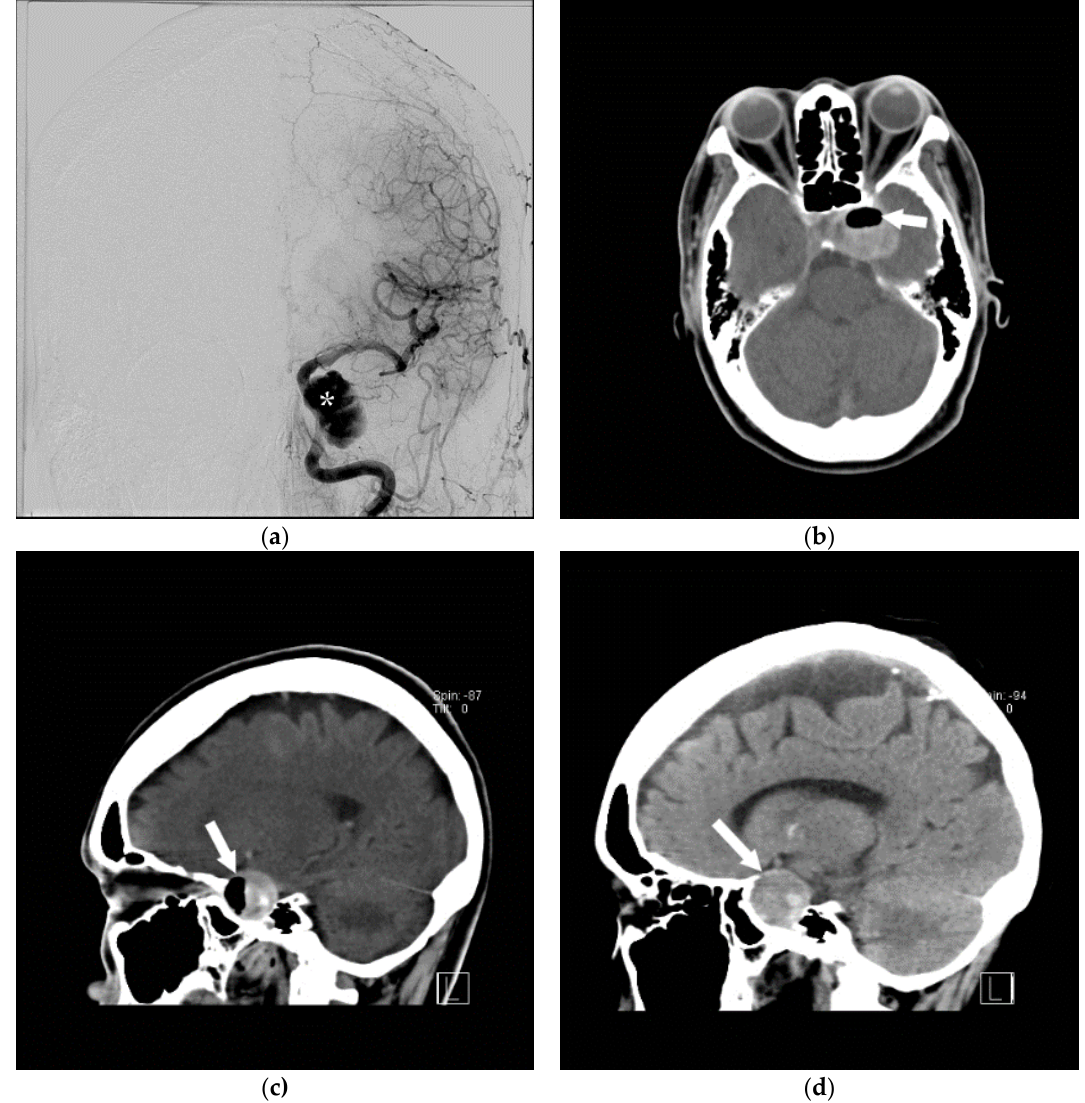
Figure 9. A 68 ‐ year ‐ old woman underwent cerebral angiogram ( a ) for evaluation of 3 cm